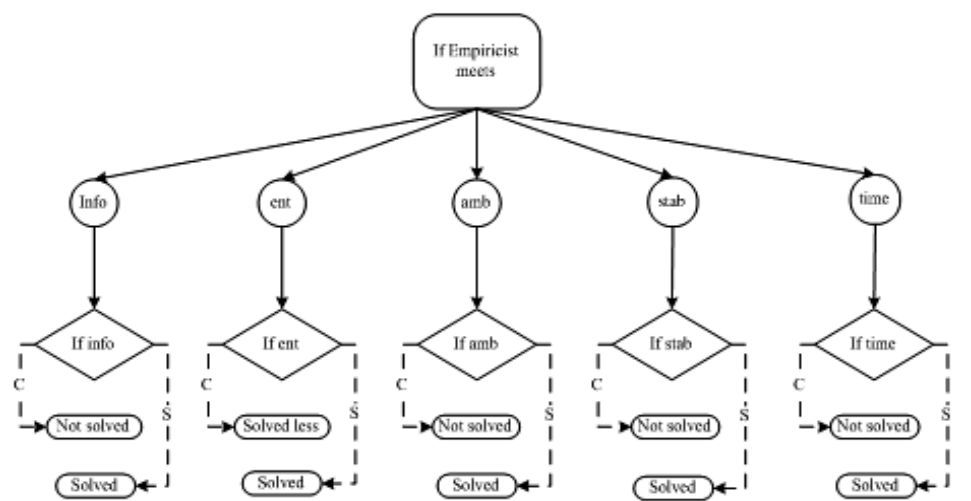
Figure 8. Sample Interaction Rules for Empiricist Agent